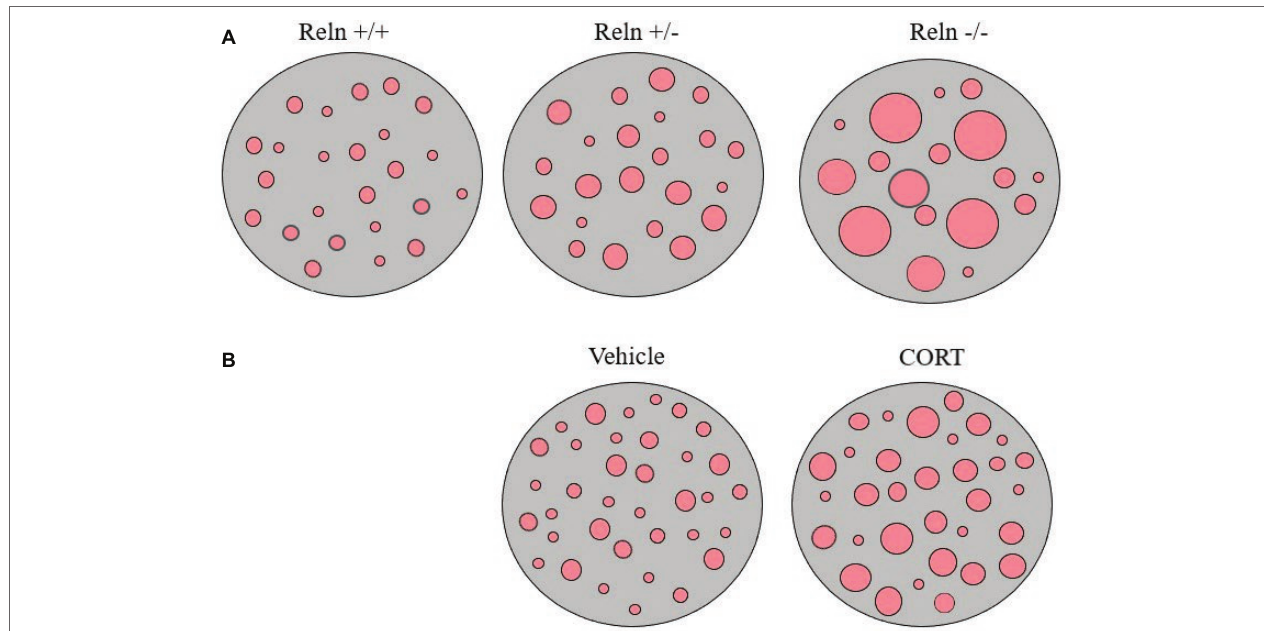
FIGURE 1 | Schematic representation of serotonin transporter (SERT) clusters in the plasma membrane of one representative lymphocyte in reeler mice (A) and in rats treated with corticosterone (B) . Note that heterozygous reeler mice (Reln +/ − ) have an increase in SERT cluster number and size in comparison to wild-type mice (Reln +/+) and that homozygous reeler mice (Reln − / − ) show much larger clusters that sometimes are difficult to differentiate [see Panel (A) , and Rivera-Baltanas et al., 2010]. After repeated-corticosterone treatment, a well-defined animal model of depression, SERT clusters also appear to increase in size [see Panel (B) , and Romay-Tallon et al.,